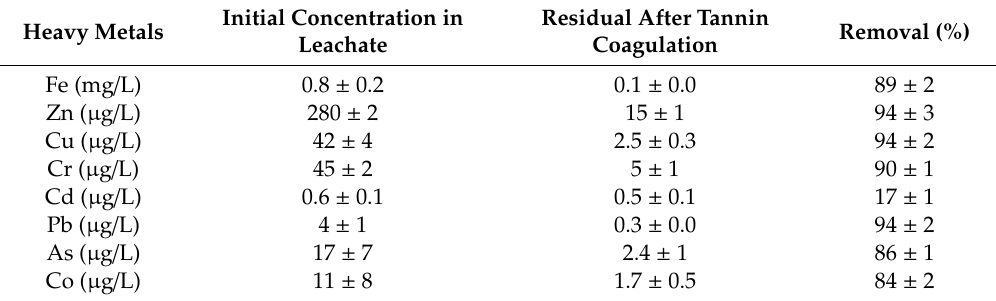
Table 6. E ff ect of tannin on heavy metal removal (tannin dosage 0.73 g, pH 6, 250 rpm for15 min, 60 rpm for 30 min and 30 min of